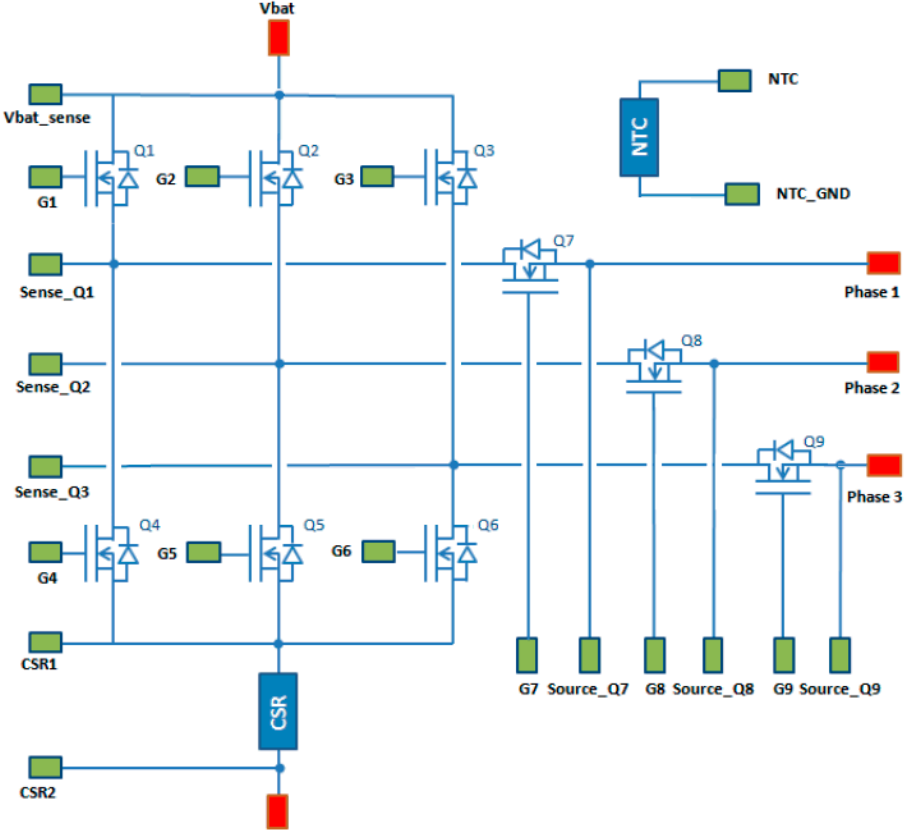
Figure 27. Circuit scheme of an automotive Engine Control Unit module.